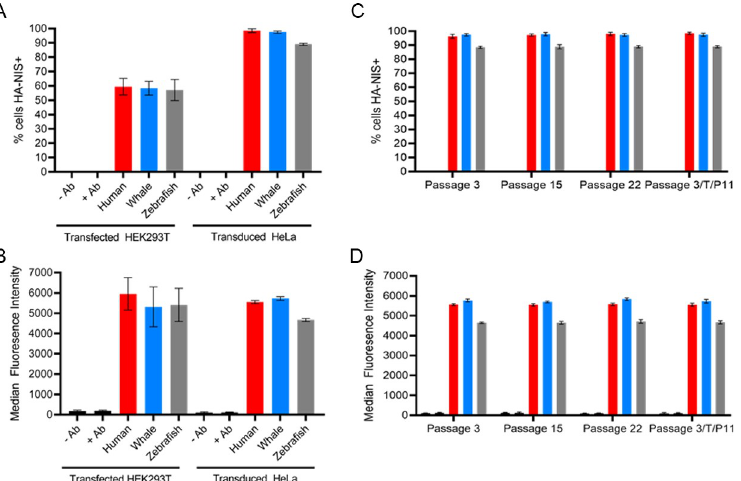
Fig 3. Flow cytometry characterization of transfected HEK293T cells and transduced HeLa cells expressing HA- human NIS, HA-minke whale NIS, and HA-zebrafish NIS. (A) Percentage of cells positively stained with α - HA-AlexaFluor647 antibody; 24-hour post transfection HEK293T cells compared to puromycin selected lentivirally- transduced HeLa cells. (B) Mean fluorescence intensity of HEK293T transfected cells or transduced HeLa cells stained with α -HA-AlexaFluor647 antibody. (C) Percentage of puromycin selected lentivirally transduced HeLa cells over several passages which were stained with α -HA-AlexaFluor647 antibody. 3/T/P11 indicates cells which were frozen at passage 3 post-puromycin selection, thawed, and grown out to passage 11. (D) Median fluorescence intensity of puromycin selected lentivirally transduced HeLa cells over several passages which were stained with α - HA-AlexaFluor647 antibody. Values are averages of triplicate assays with standard deviation. -/+ Ab refers to incubation of antibody with nontransfected/untransduced parental cell line.